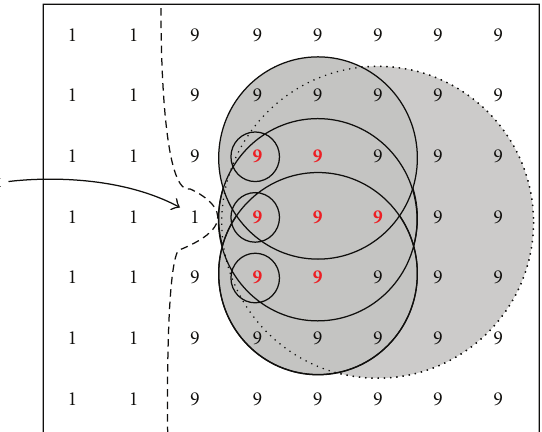
Figure 8: Synthetic test image from Figure 7(a) with gaussian noise added.